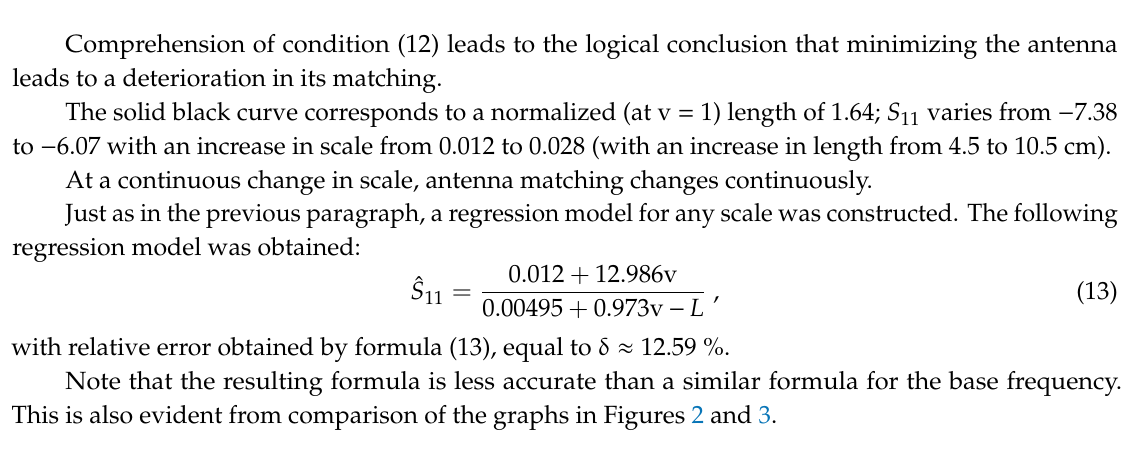
Table 2. Coefficients of regression model (4) for (cid:1845)(cid:4632) (cid:2869)(cid:2869) at the base resonance. Scale, m (cid:2193) (cid:2780) (cid:2193) (cid:2781) 0.012